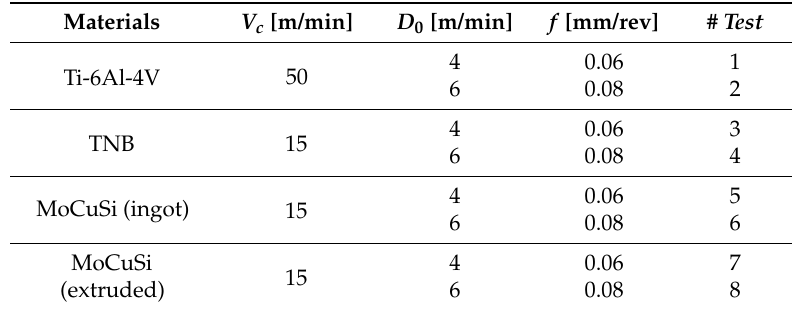
Table 9. Cutting conditions for the validation tests.